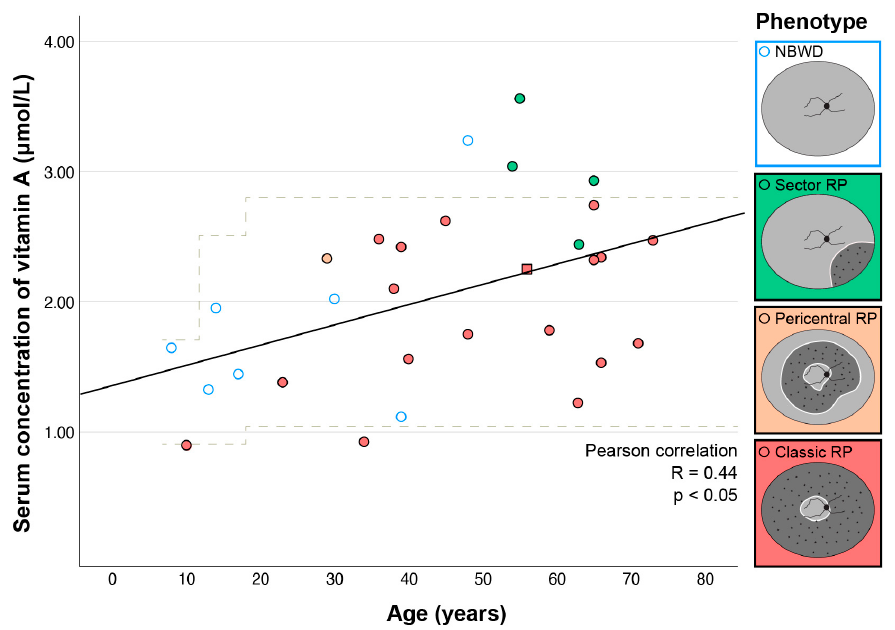
Figure 2. Correlation between serum vitamin A concentration and age. Different phenotypes are marked with different colors. The patient taking vitamin A supplements is marked with a square. Most patients with NBWD were younger than 40 years. Note that their serum concentration is relatively low (most likely due to younger age), but it is mostly higher than that of RP patients of similar ages. In patients aged ≥ 40 years, higher vitamin A concentrations were found in patients with a mild phenotype (NBWD or Sector RP) than in patients with a severe phenotype (Classic RP). The laboratory reference values were 0.91–1.71 µmol/L (7–12 years old), 0.91–2.51 µmol/L (13–18 years old), and 1.05–2.8 µmol/L (adults); marked with dashed lines. NBWD—night blindness without degeneration; RP—retinitis pigmentosa.